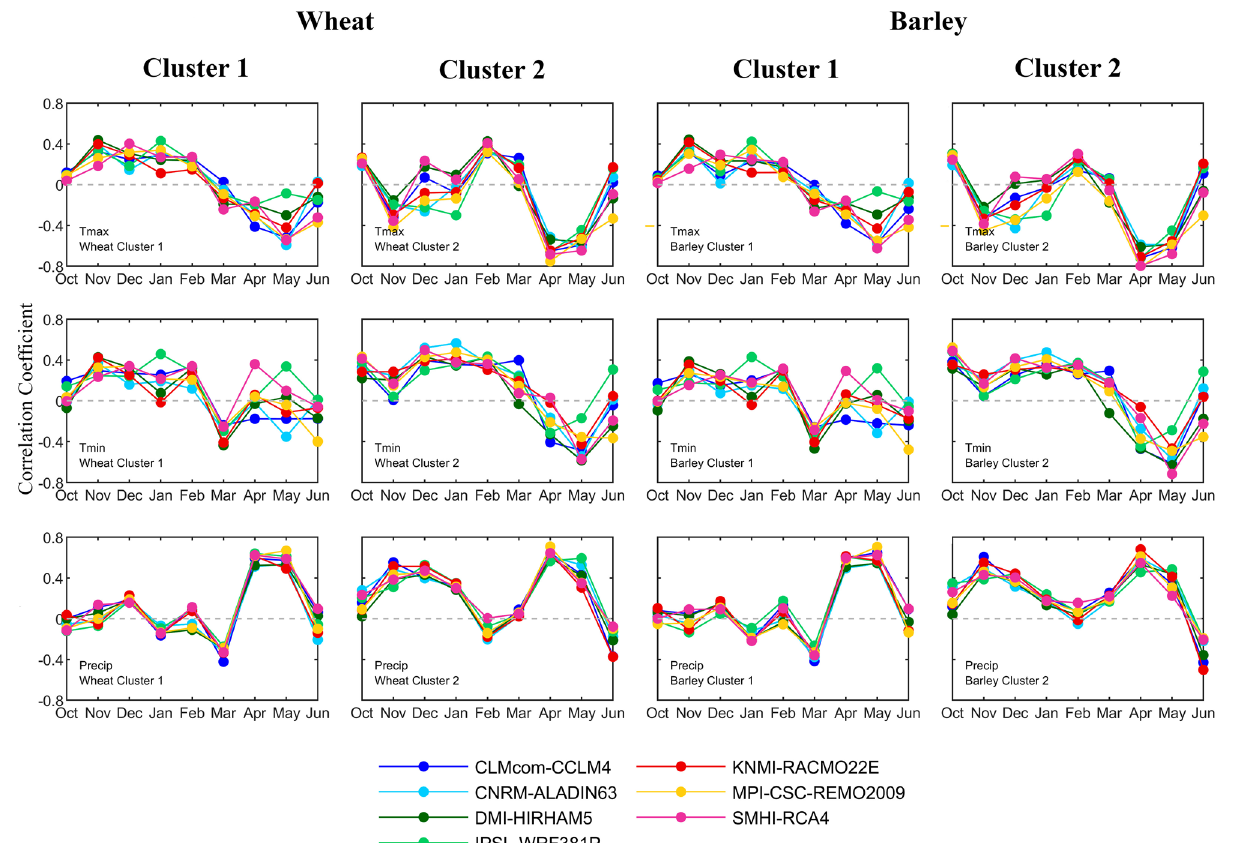
Figure 2. Correlation between standardized detrended yield anomaly of wheat (left panels) and barley (right panels) and CORDEX-Evaluation models standardized detrended precipitation (bottom), Tmax (top), and Tmin (middle) for cluster 1 and cluster